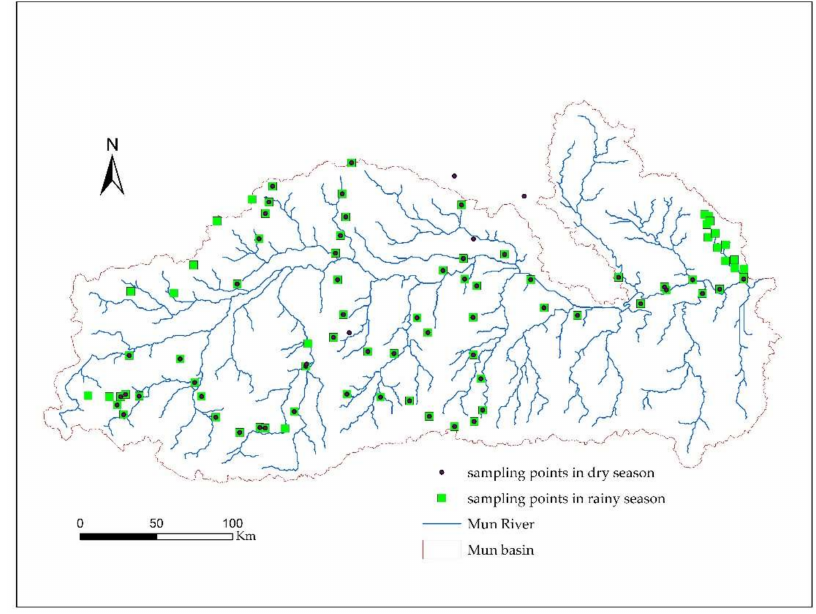
Figure 2. Distribution map of the soil sampling